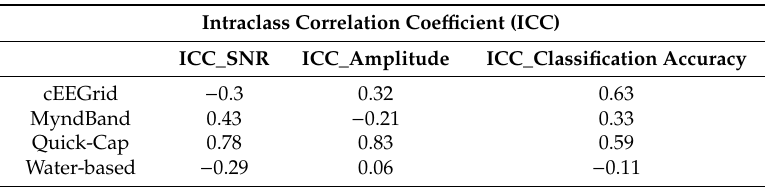
Table 3. Test–retest reliability of the signal-to-noise ratio (SNR), average amplitude around the movement onset and the classification